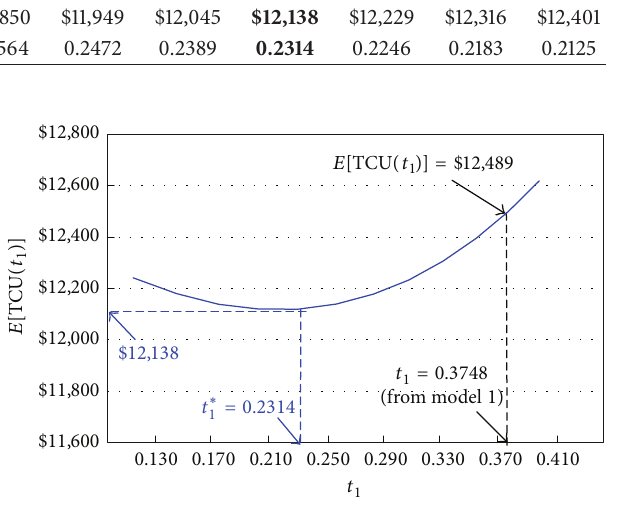
Figure 7: The behavior of 𝐸[ TCU (𝑡 1 )] with respect to production run time 𝑡 1 in the proposed model